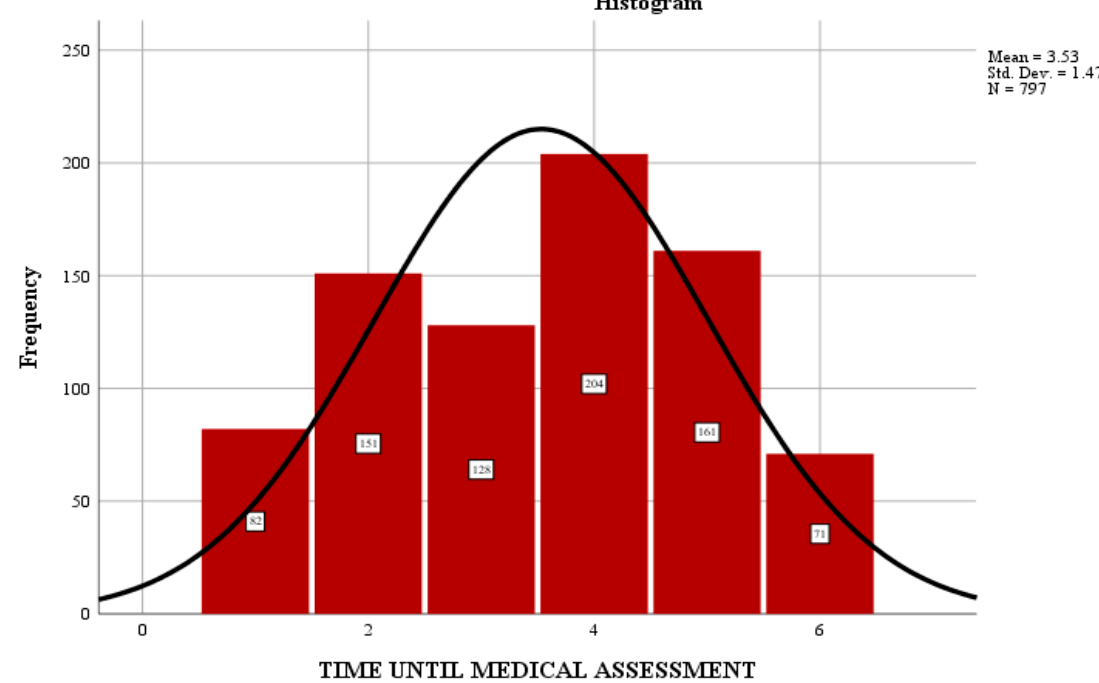
Figure 2. Distribution of cases according to the time interval from exposure to ED arrival .